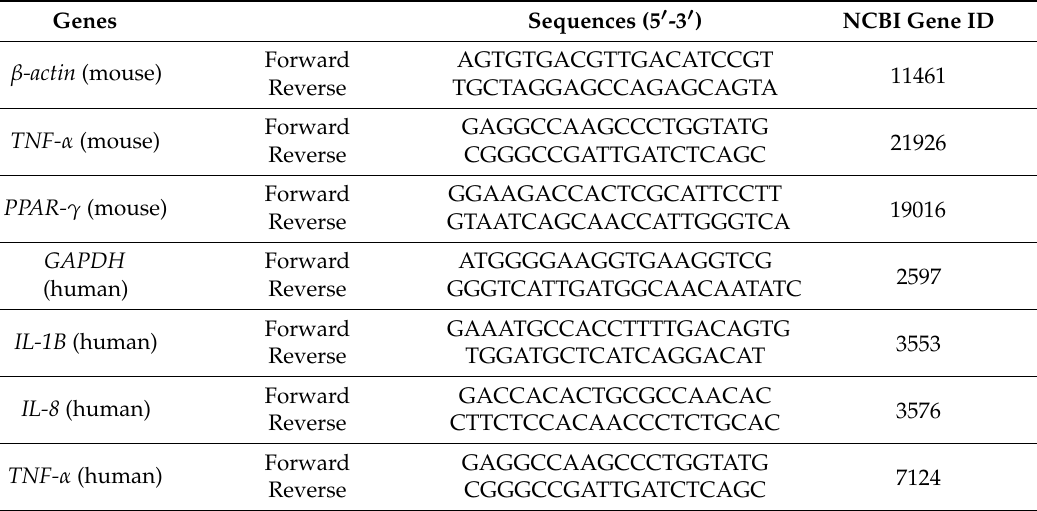
Table 1. Quantitative Real-Time Polymerase Chain Reaction (qRT-PCR) primers sequences used in this